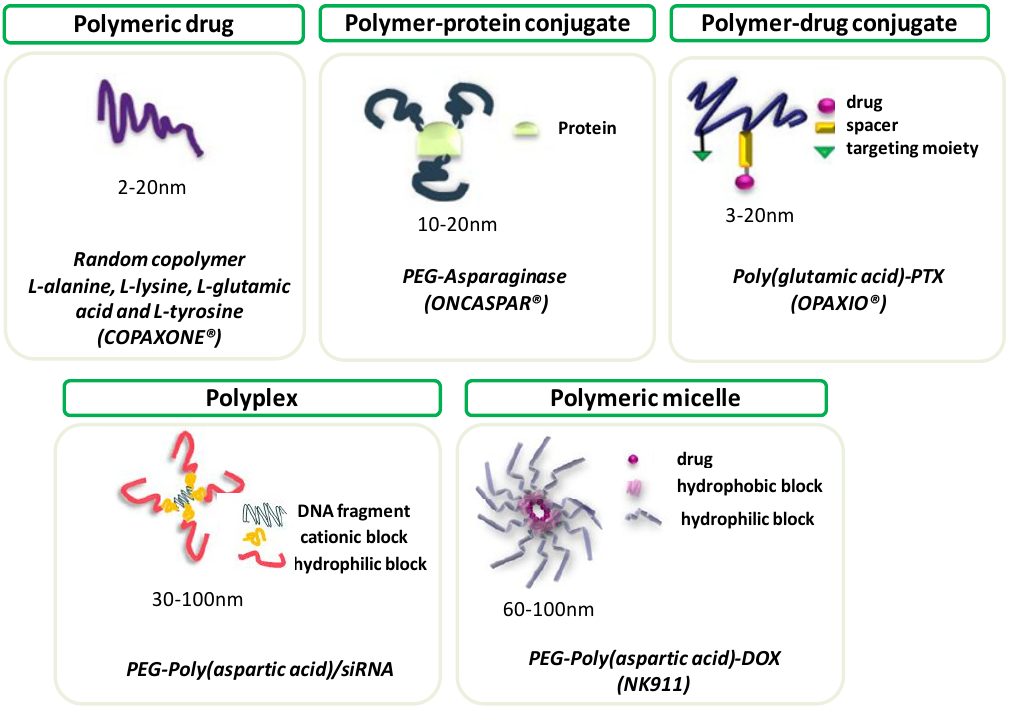
Figure 1. Schematic representation of polymer therapeutic families. Adapted from